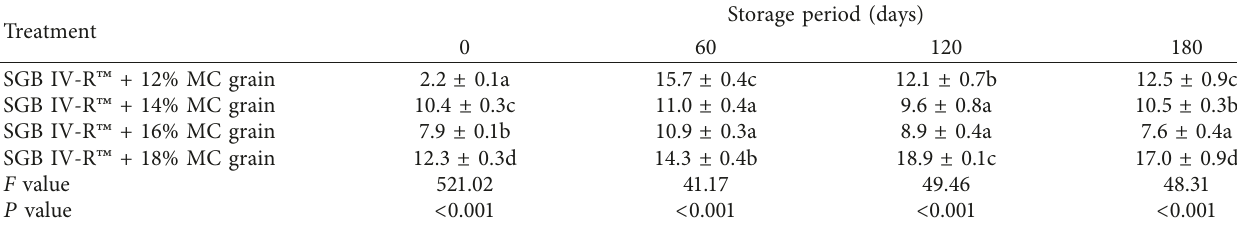
Table 6: Mean% ( ± SE) carbon dioxide levels within SuperGrain IV-R ™ bags after 60, 120, and 180 days of storage.